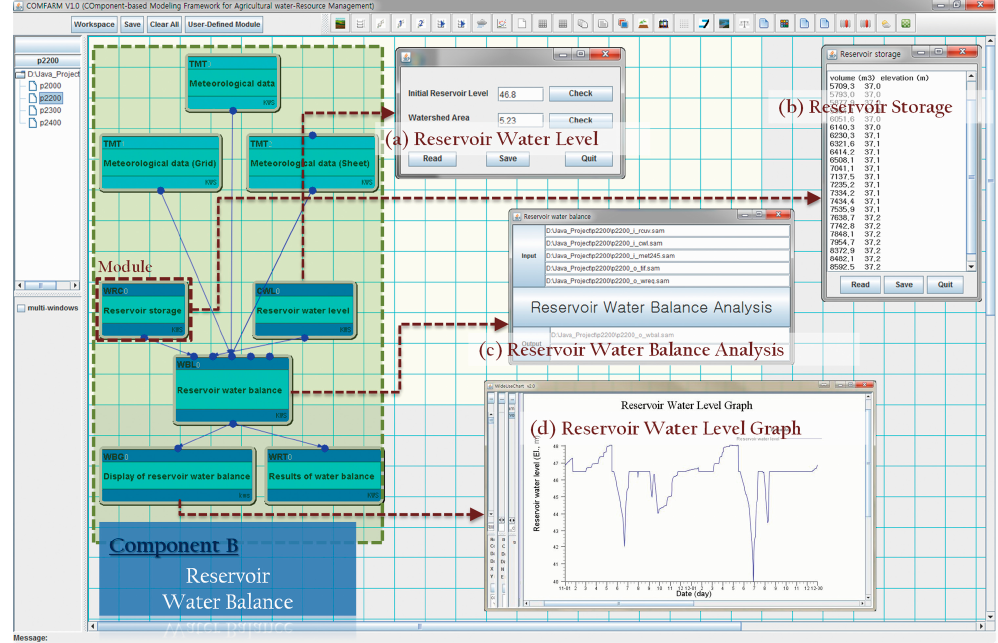
Figure 7. Reservoir water balance. Dialog boxes: ( a ) sets the initial reservoir levels; ( b ) determines the reservoir storage; ( c ) analyzes reservoir water balance; and ( d ) displays the average annual reservoir water balance.